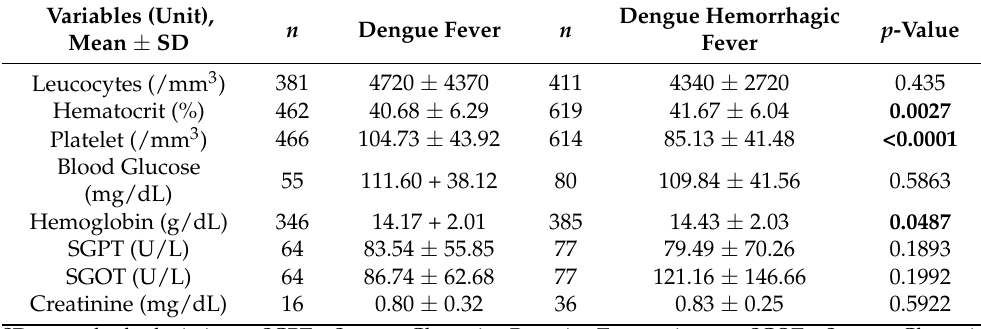
Table 3. Biochemical Laboratory Data of Dengue Patients at First Day of